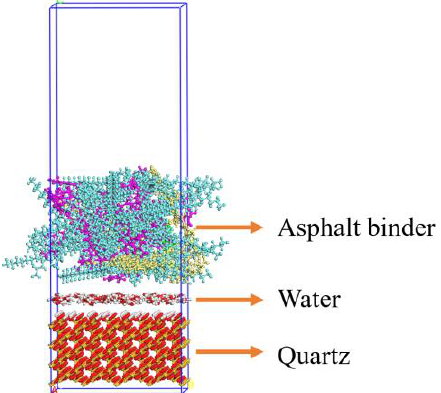
Figure 3. Triple-layer interface model of SBS modified asphalt binder – water – aggregate.